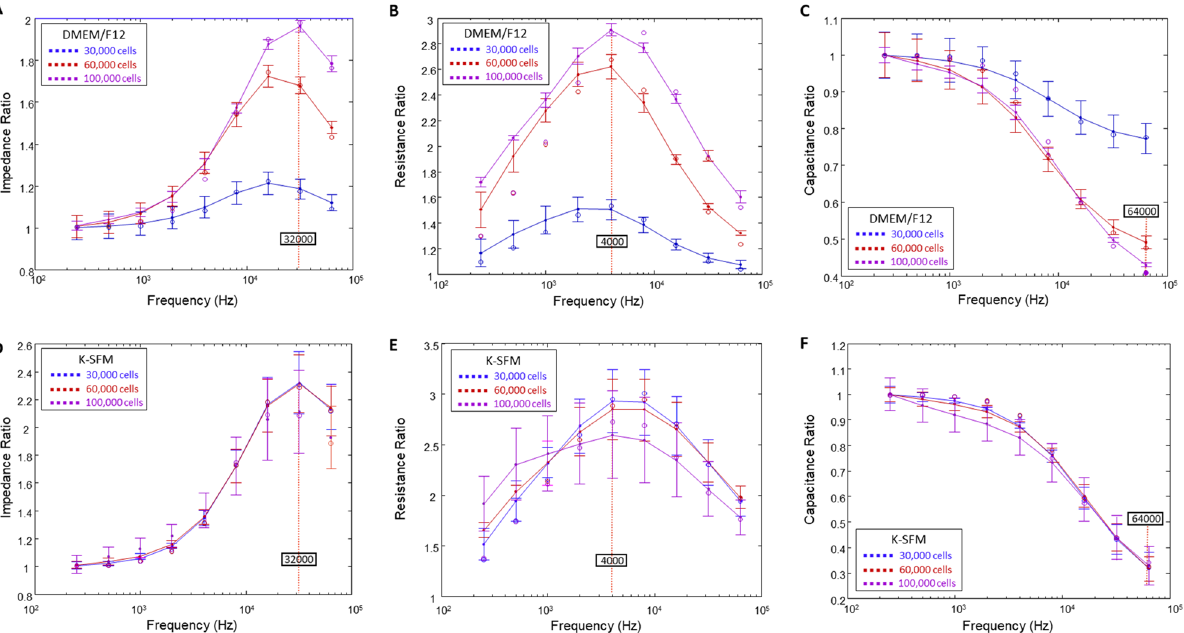
Figure 2. Determination of optimal AC frequencies using frequency dependence spectra. Data are presented as ratios of cell to cell-free measurements (y-axis) versus frequency (x-axis) measured at 15 h. Tracings are shown for impedance ratios with a maximum response at 32 kHz ( A , D ), resistance ratios with a maximum response at 4000 Hz ( B , E ), and capacitance ratios with a minimum response at 64 kHz ( C , F ) from HUCLs grown in DMEM/F12 ( A – C ) and K-SFM ( D – F ), respectively. Data shown are the mean ± SEM; n =